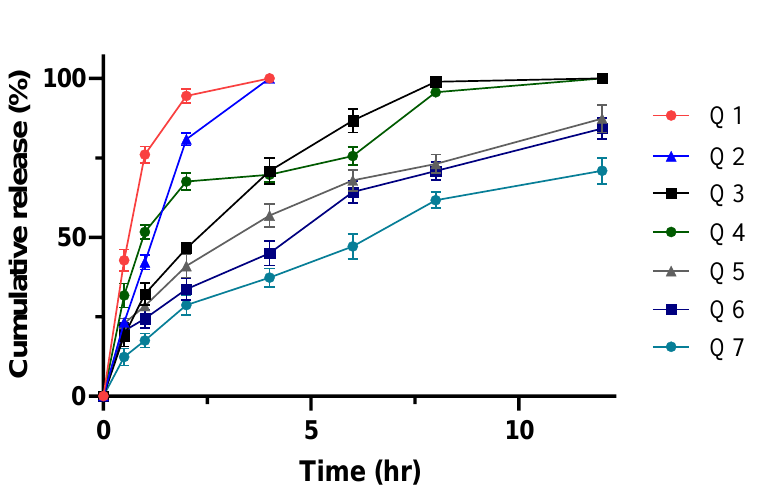
Figure 6. In vitro DXM release using PBS 6.8 media.